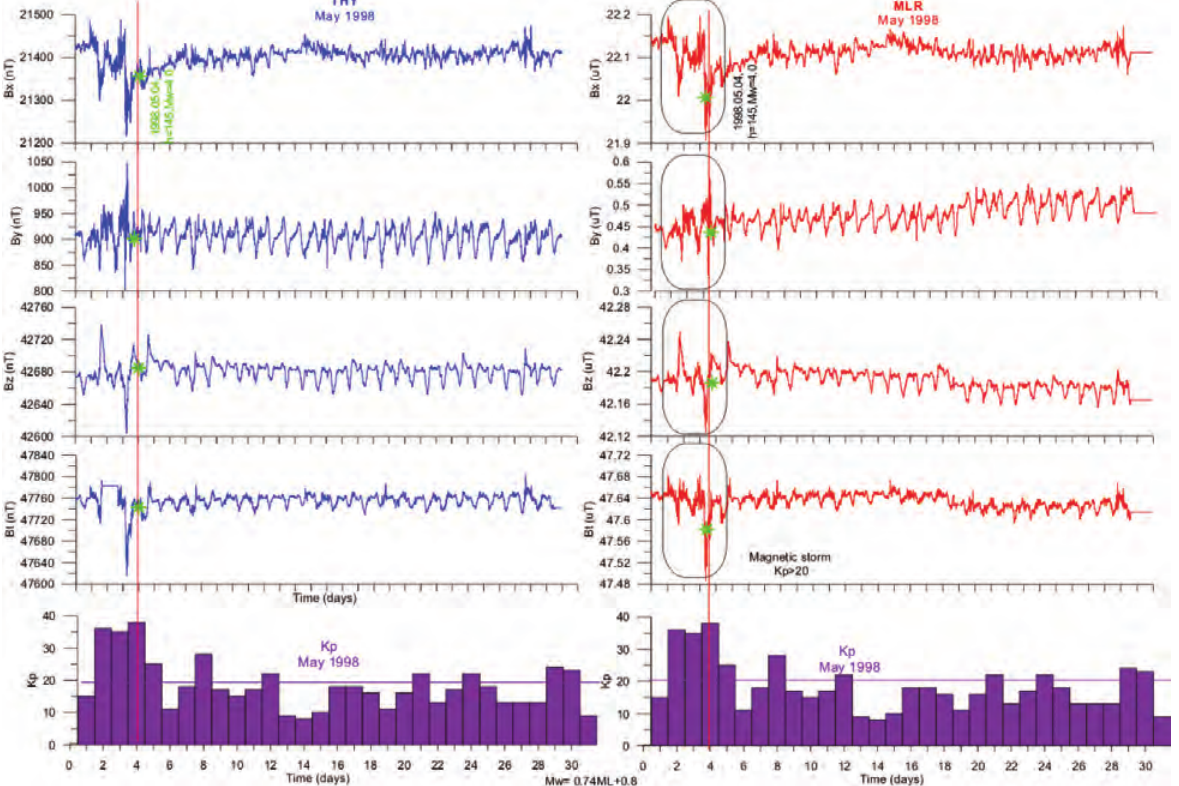
Figure 2. Solar storm that took place on May 2, 3, 4, 1998, had a triggering effect on the earthquake that occurred on May 4, 1998 Mw 4.0; h = 145 km). In this case, the geomagnetic anomaly was induced by the solar storm (as the Kp index reveals) and it is not a seismo-magnetic